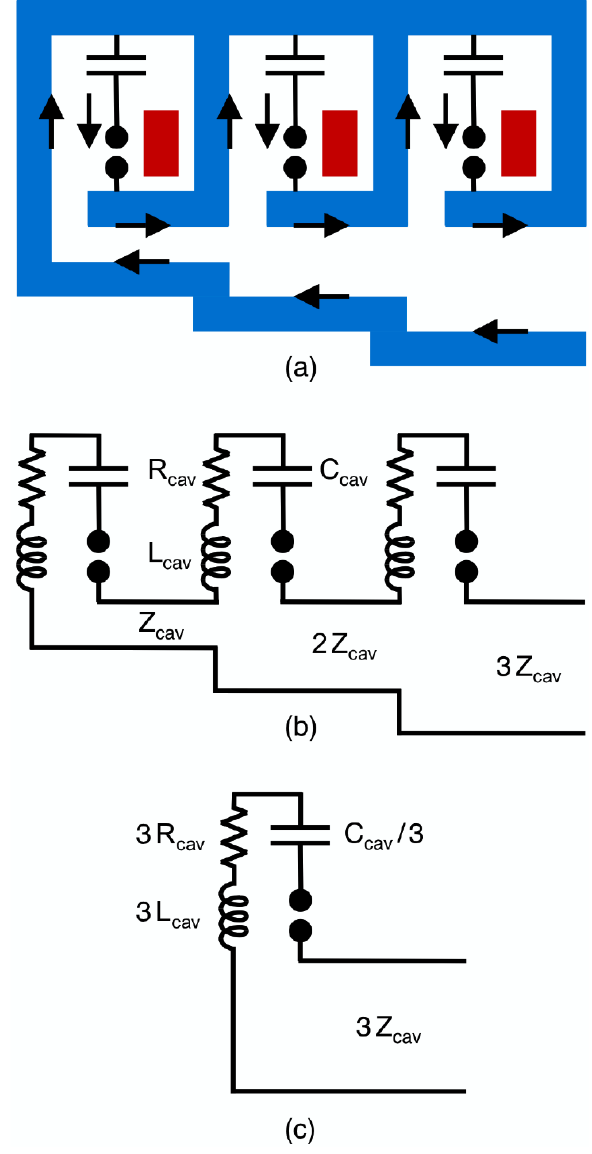
FIG. 5. (Color) (a) Idealized representation of a 3-cavity LTD module. Each cavity contains 80 capacitors and 40 switches; these are represented here by a single capacitor and a single switch. The red rectangles represent magnetic cores. The arrows represent the path of most of the current flow, after all the switches in the cavities have closed. We neglect here the small fraction of the current that flows around the inductive cores. The LTD module assumed in Secs. IV and V consists of 60 cavities. (b) Circuit diagram of the 3-cavity module, neglecting losses due to the cores [76,79,86]. (c) Equivalent circuit model of the module [76,79,86]. This circuit is valid only when the switches later than the closure of a given cavity close at a time that is (cid:2) cav is of the switches in the cavity immediately to the left, where (cid:2) cav the time it takes an electromagnetic pulse to propagate (down the is the transmission line) the length of a single cavity. Hence (cid:2) cav one-way transit time of a single transmission-line segment. We assume here that all the cavities, and all the transmission-line segments, have the same electrical